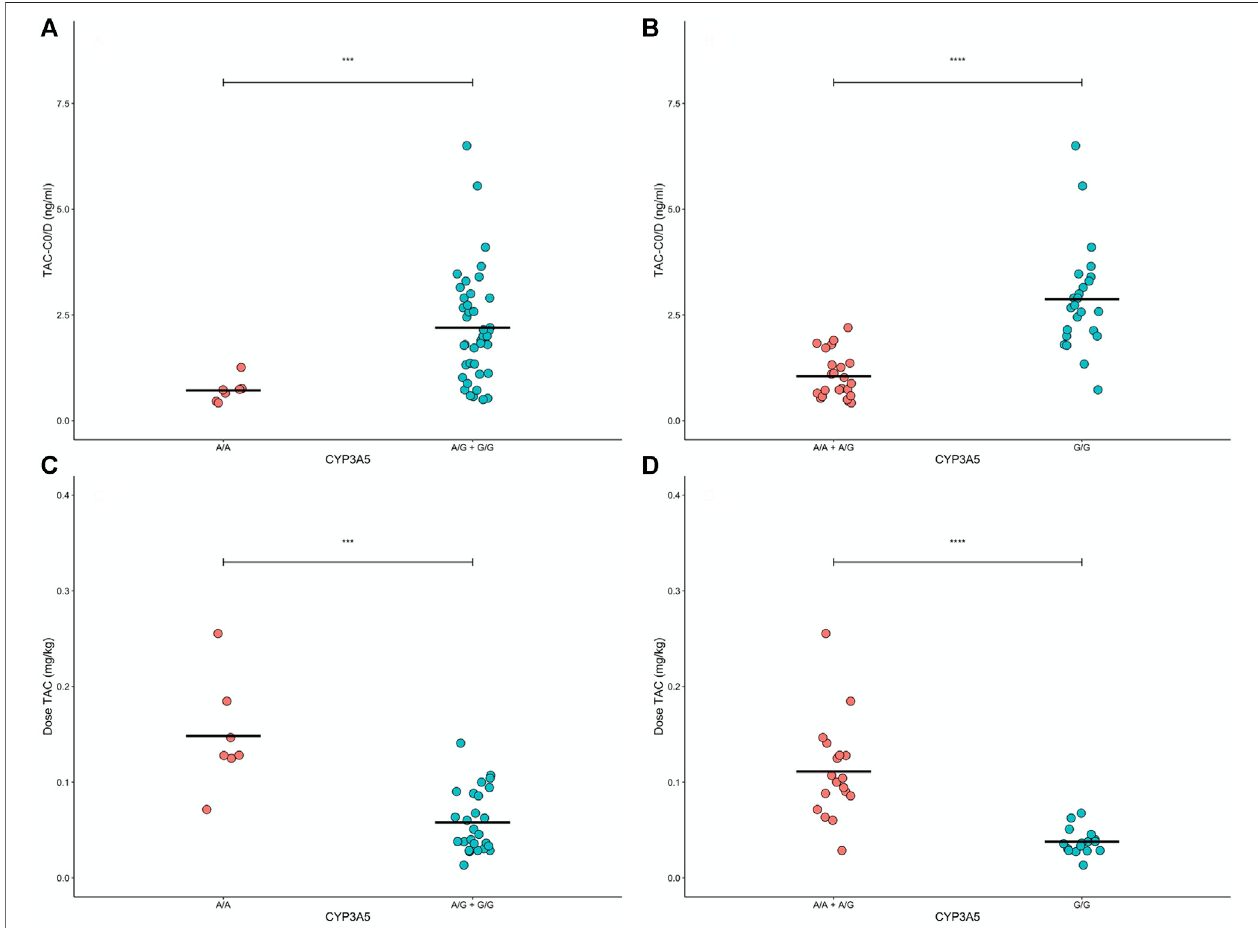
FIGURE 4 | Levels of tacrolimus (TAC) normalized by dose before administration (TACC0/D) and tacrolimus dose standardized by patient weight according to dominant (A,C) and recessive (B,D) modes for CYP3A5 gene, respectively. ANOVA results are indicated as signi fi cant differences between grouped genotypes (*** p < 0.001, and **** p <